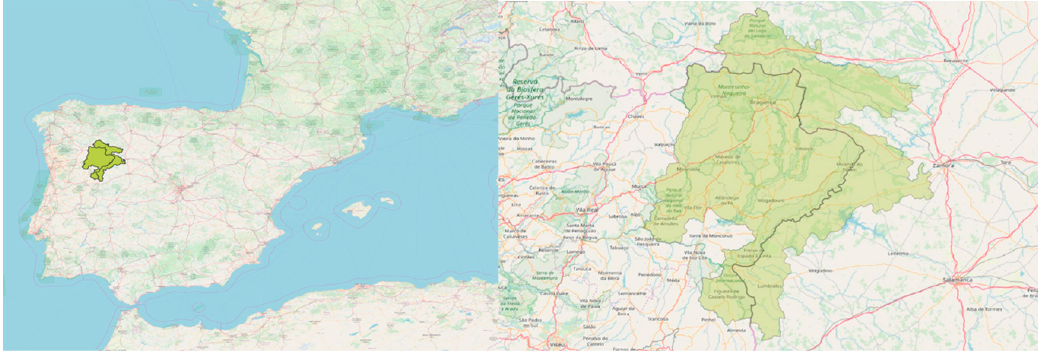
Figure 1. Maps of the Iberian Plateau Biosphere Reserve. Source: Mapama (2019).